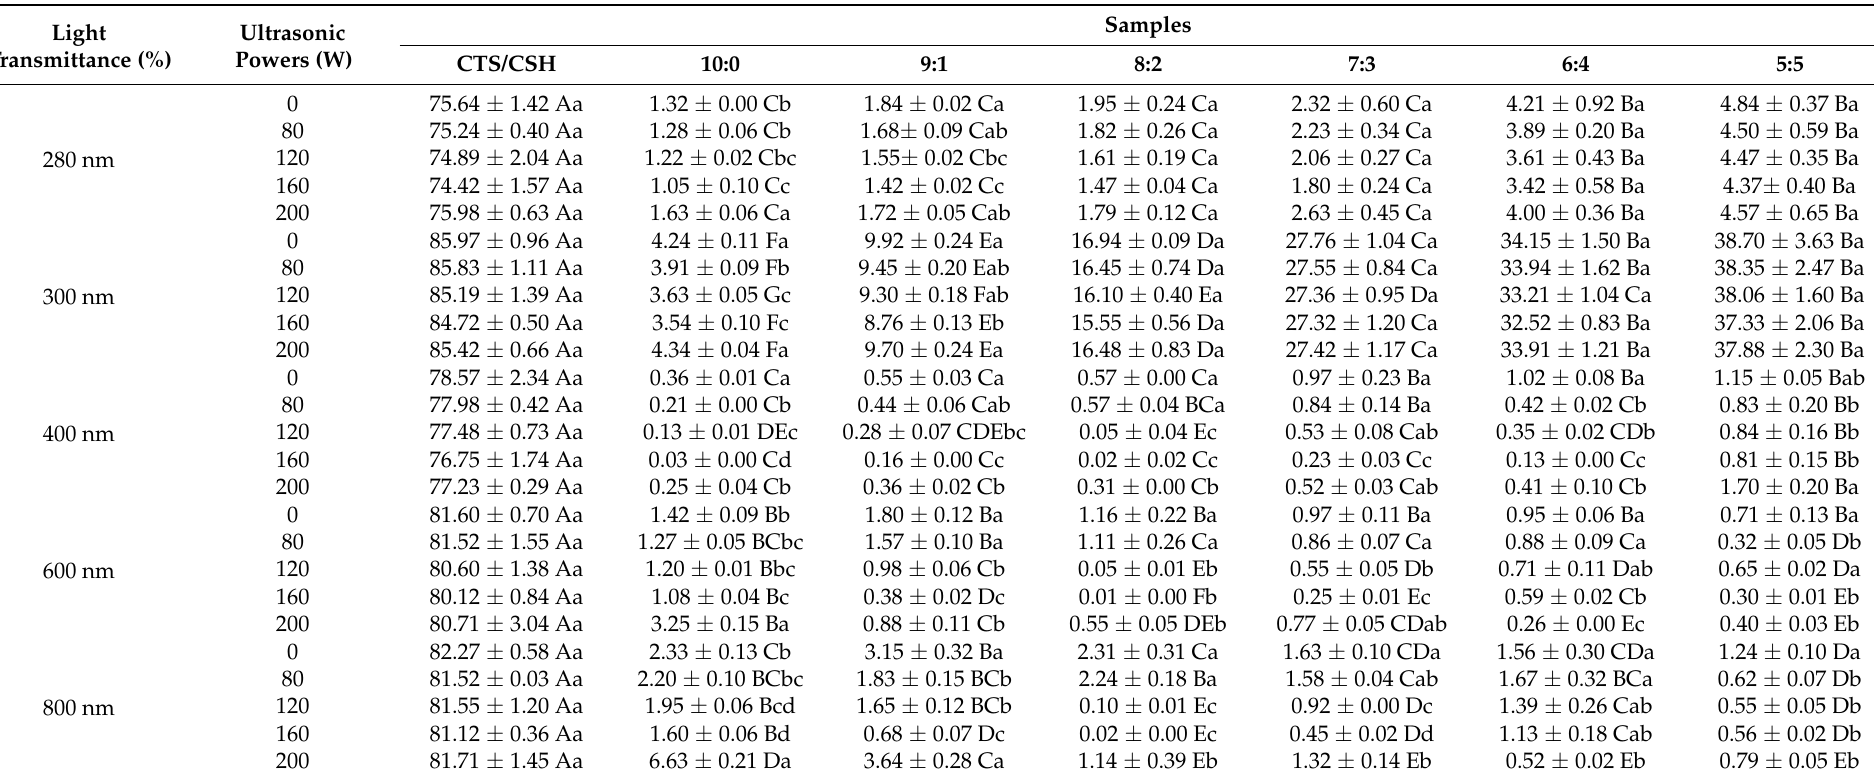
Table 4. Light transmittance values of CTS/CSH, CTS/CH/TiO 2 , and different CTS/CH/TiO 2 /Gr composite membranes under different ultrasonic